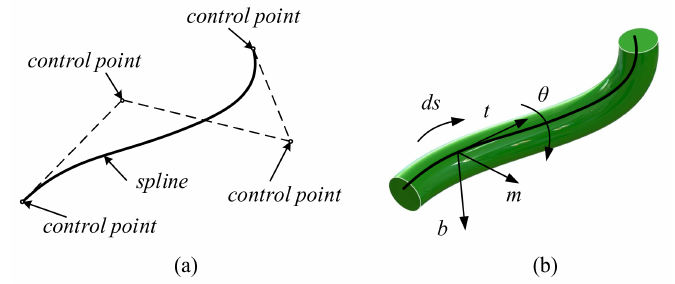
Figure 1. A spline model ( a ) and Frenet frame of the spline curve ( b